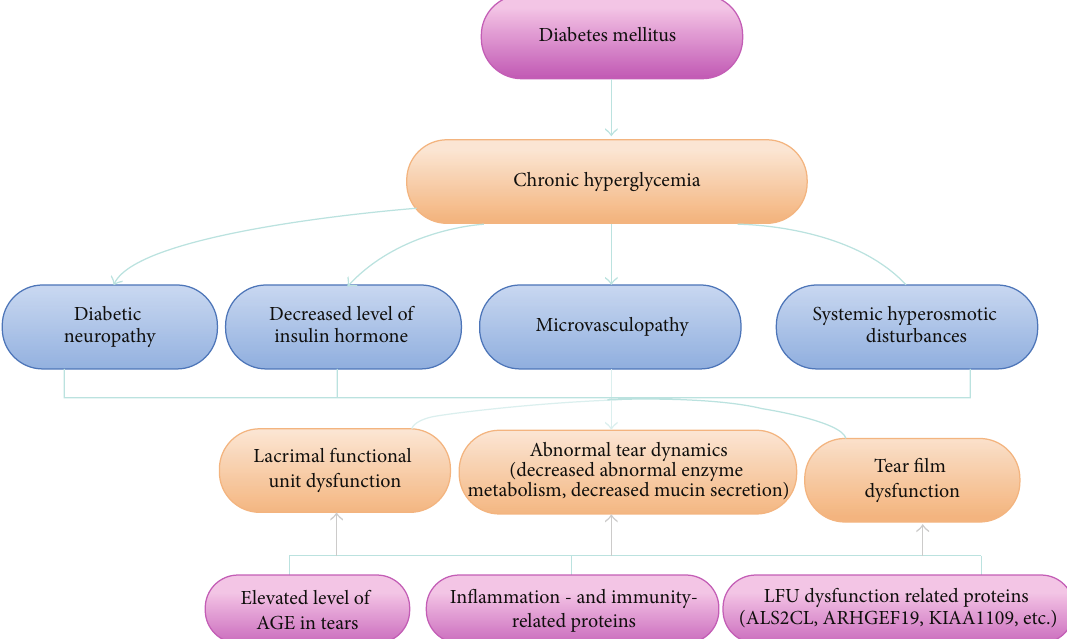
Figure2:Etiologyandpathogenesisofdiabetesmellitusassociateddryeyesyndrome.Chronichyperglycemia,diabeticperipheryneuropathy, decreased insulin hormone, microvasculopathy, and systemic hyperosmotic disturbances are risk factors for diabetes-associated dry eye syndrome, which subsequently induce lacrimal function unit and tear film dysfunction and abnormal tear dynamics. Several proteins have been identified to be the contributor to diabetes mellitus associated dry eye